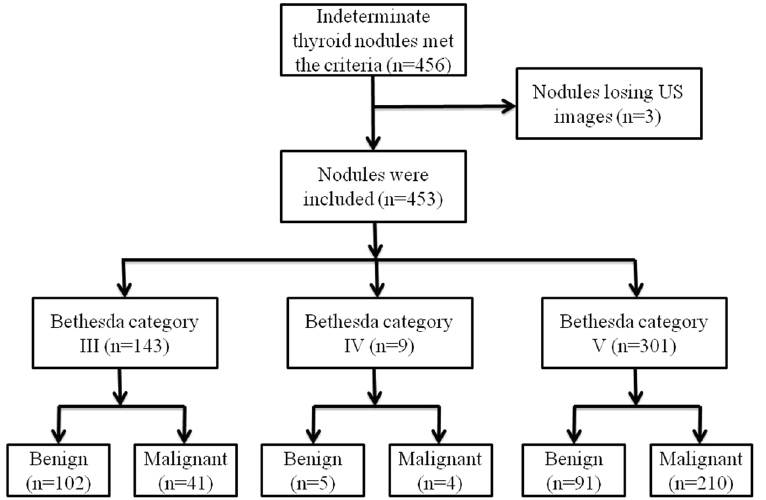
Figure 1. Flowchart of selected patients with thyroid